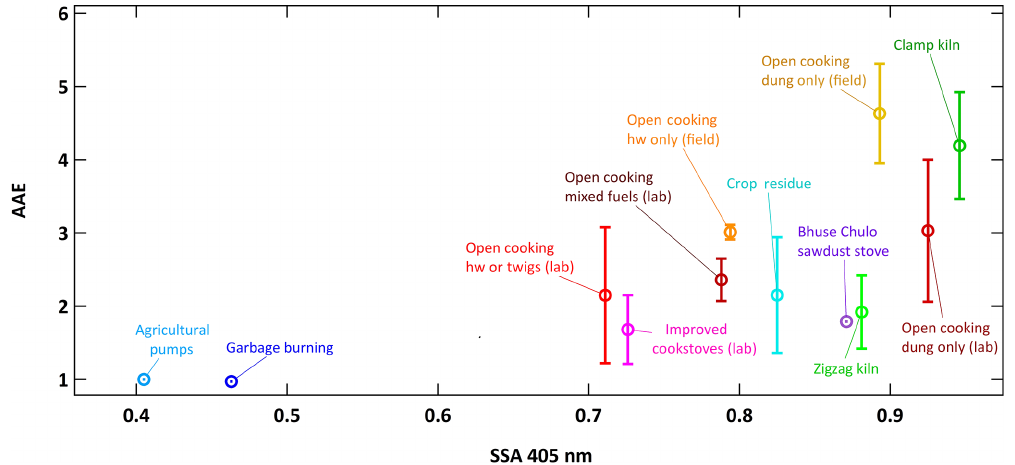
Figure 1. The absorption Ångström exponent (AAE) calculated at 405 and 870nm as a function of single scattering albedo (SSA) at 405nm for fuel types measured during the NAMaSTE campaign. The error bars represent ± 1 standard deviation of the AAE measured for different burns (or different samples in the case of brick kilns). Note: “hw” indicates hardwood fuels. The AAE for agricultural pumps was not measured but is assumed to be 1 because the SSA at 405nm was indicative of pure BC. AAE was only measured on one garbage burning fire (value of 0.971) though the SSA at 405nm on another garbage burning fire indicates that its AAE was larger than 1.